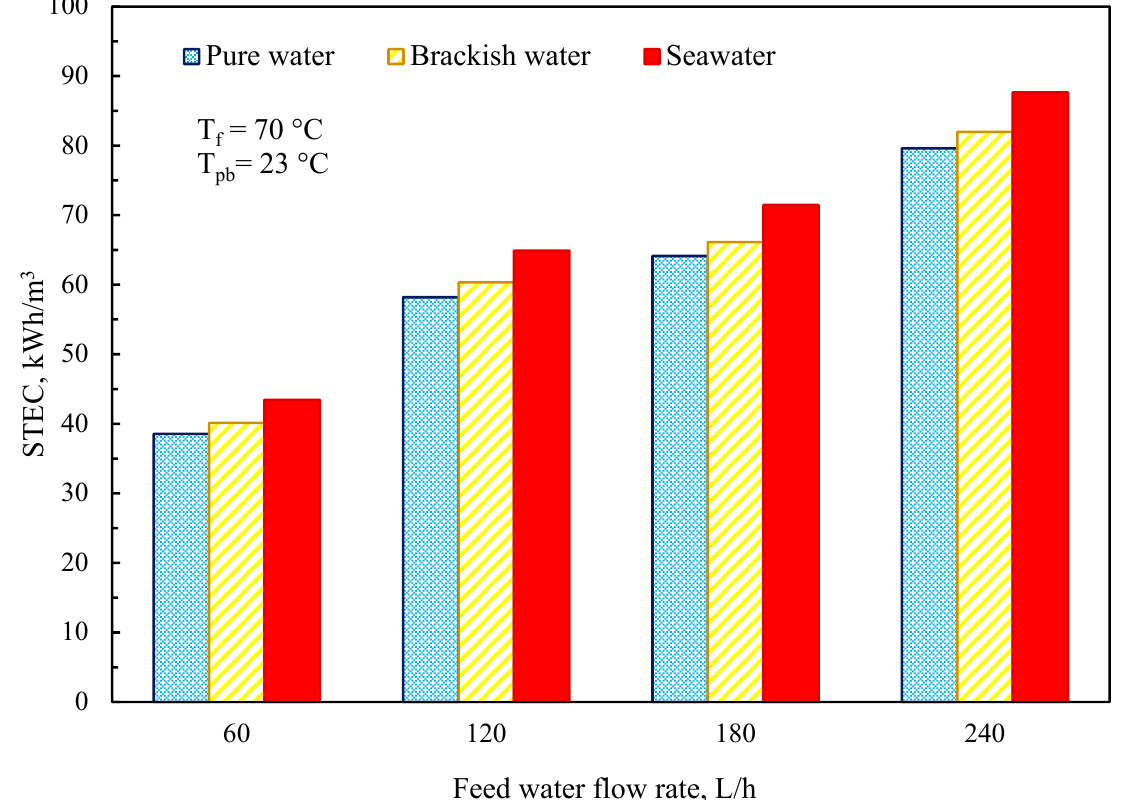
Figure 8. Feed Reynolds number versus feedwater flow rate ( T fb = 70 °C, T pb = 23 °C). Also, the average Nusselt number increases by increasing the Reynolds number due to an increase in convection heat transfer over the membrane surface (Figure 9).